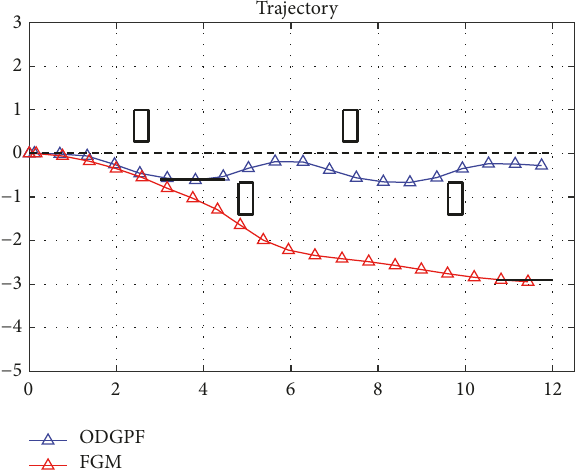
Figure 21: Maximum deviation from the initial direction line.